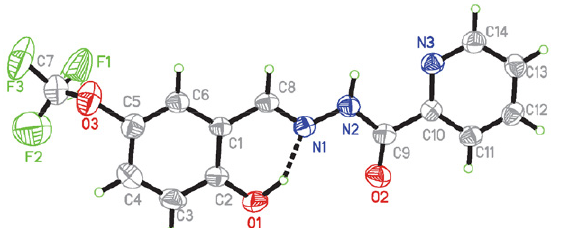
Figure 3. A perspective view of the molecular structure of 3 with the atom labeling scheme. Thermal ellipsoids are drawn at the 30% probability level. Hydrogen bonds are shown as dashed lines.